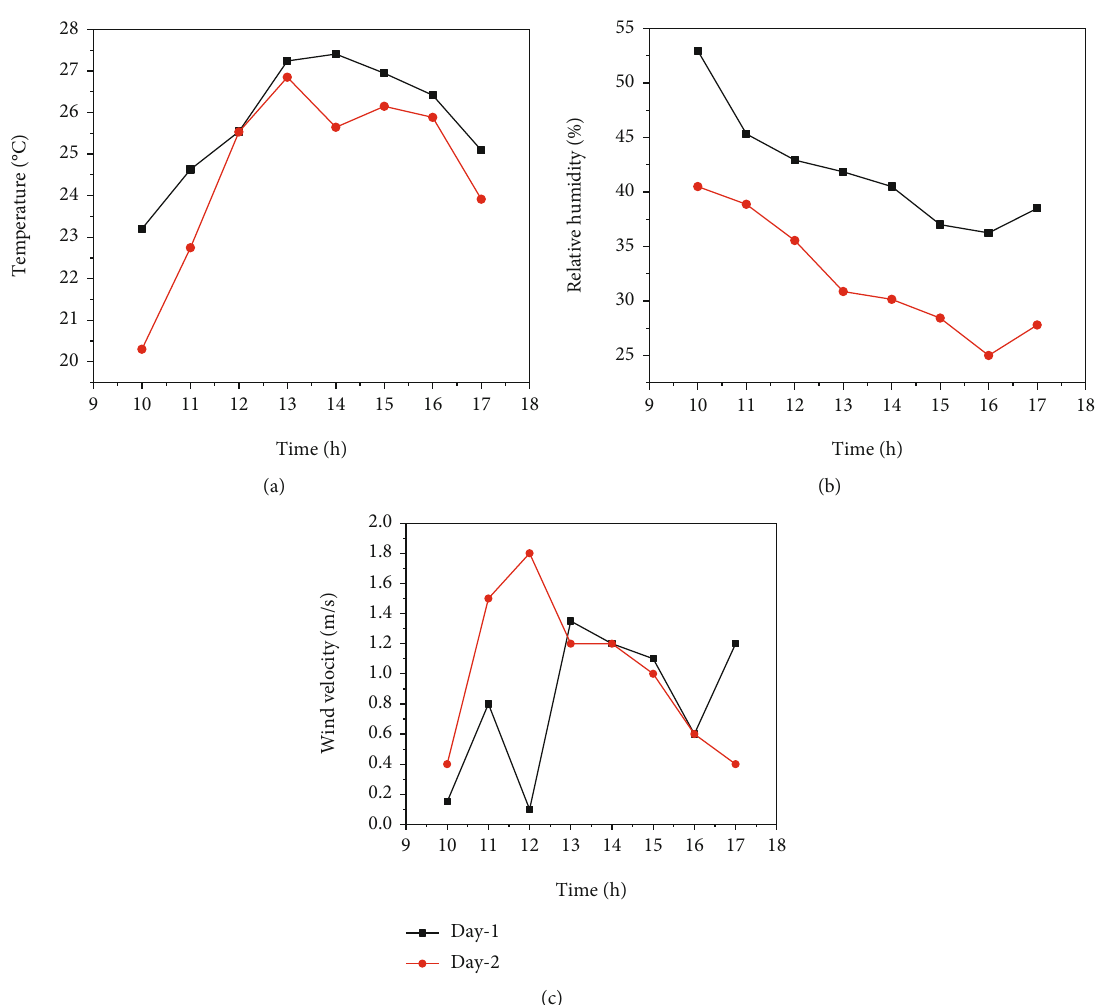
Figure 4: Variation of air (a) ambient temperature, (b) ambient relative humidity, and (c) wind velocity with time of day-1 and